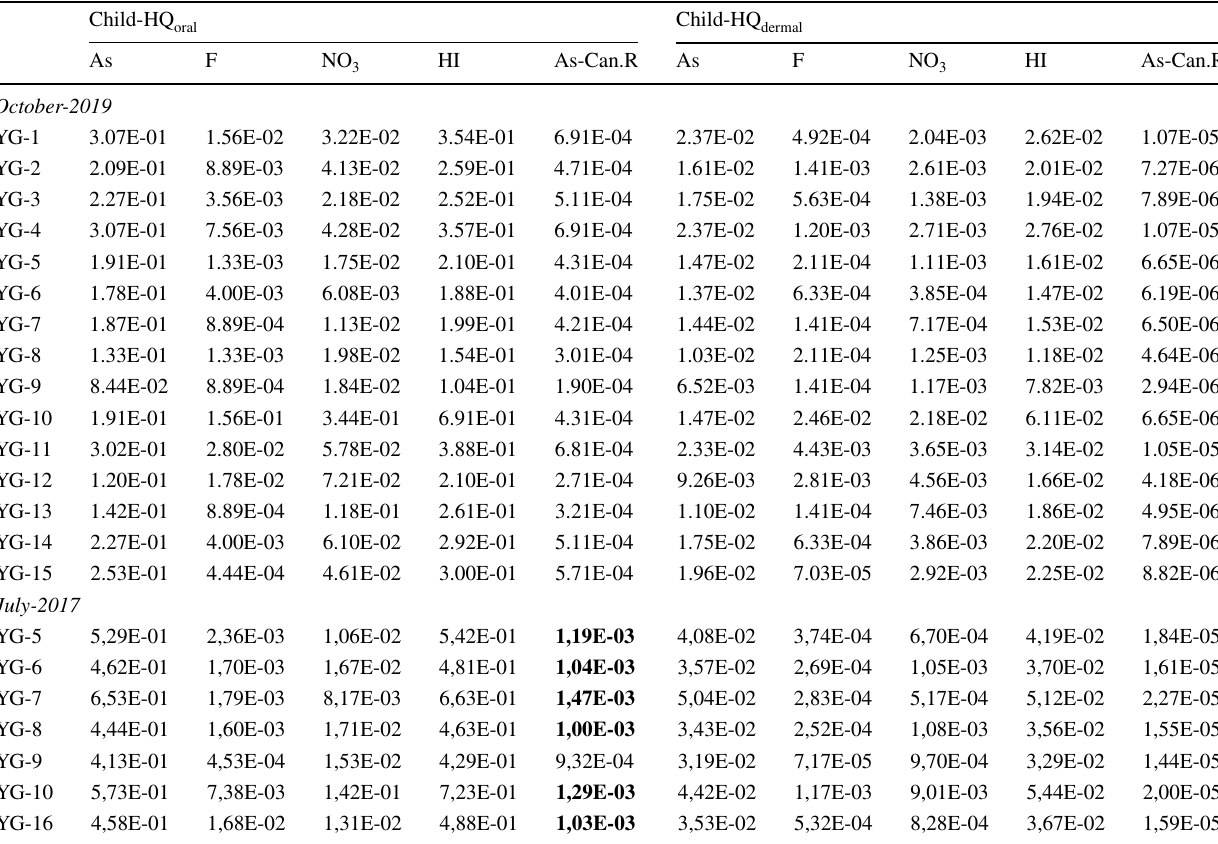
Table 8 Hazard index for each element and cancer risk of As for child